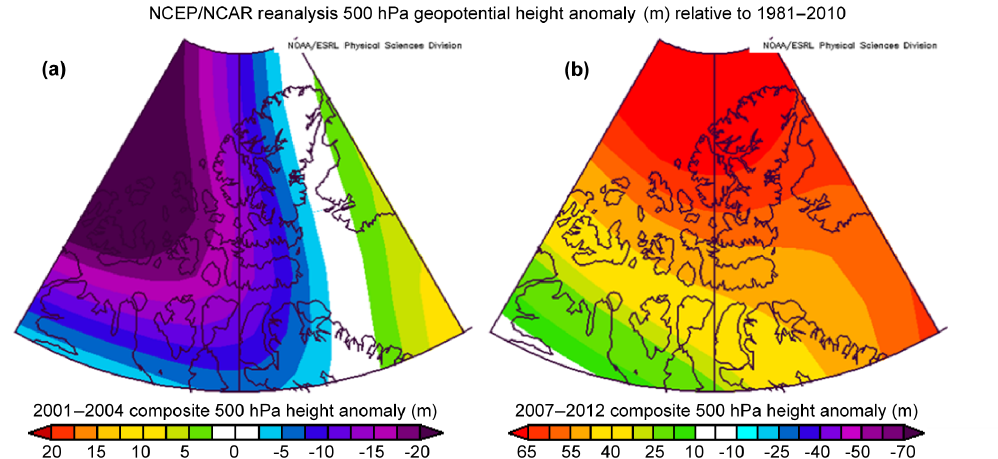
Figure 4. Mean summer (JJA) composite NCEP/NCAR Reanalysis 500hPa geopotential height anomaly for (a) a period of large negative BSA anomalies (2001–2004) and (b) a period of large positive BSA anomalies (2007–2012). Source: https://www.esrl.noaa.gov/psd. Table 2. Clear-sky mean summer monthly BSA a and BSA a anomaly relative to the 2001–2016 mean for the QEI ice cover; ± 1standard deviation. June July August June anomaly b July anomaly b August anomaly b